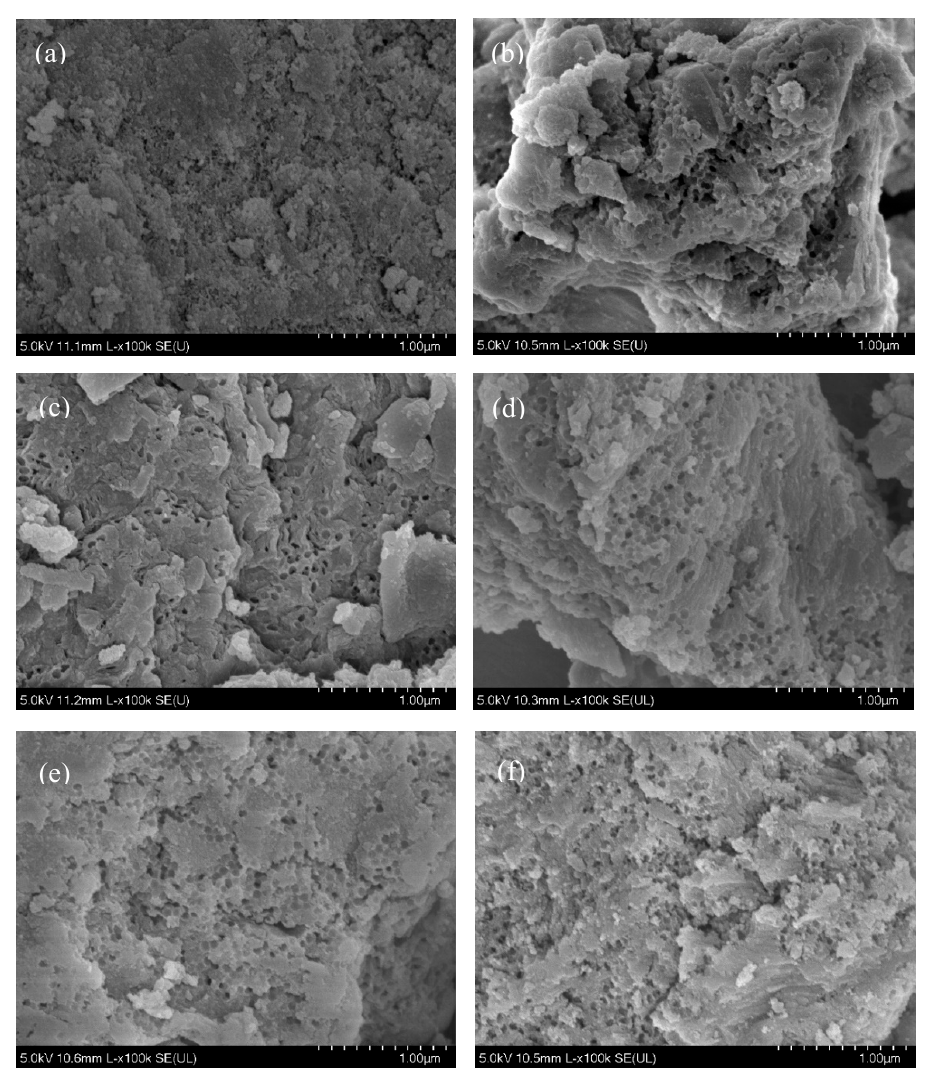
Figure 4. Scanning electron microscope (SEM) images of M100-MA ( a ), 4%Ni/M100-MA ( b ), 6%Ni/M100-MA ( c ), 8% Ni/M100-MA ( d ), 10% Ni/M100-MA ( e ), and 12% Ni/M100-MA ( f ).